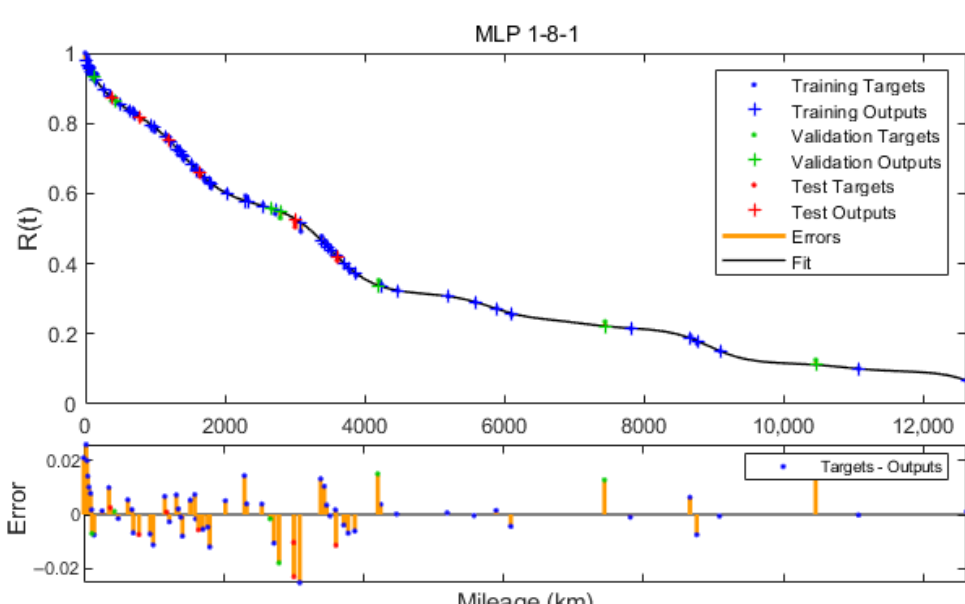
Figure A7. Reliability function approximated by MLP 1-8-1.